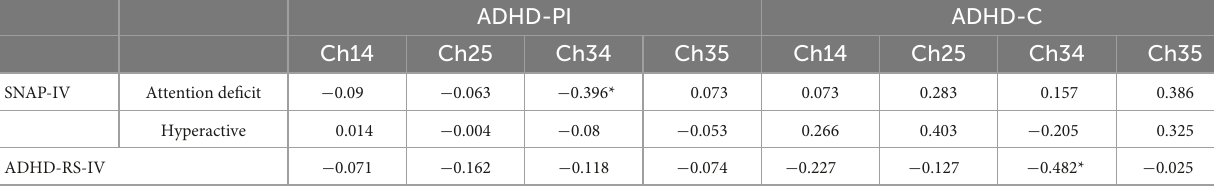
TABLE 4 The correlation between scale score and channel